Question: Briefly state, in one sentence, what is plotted here.
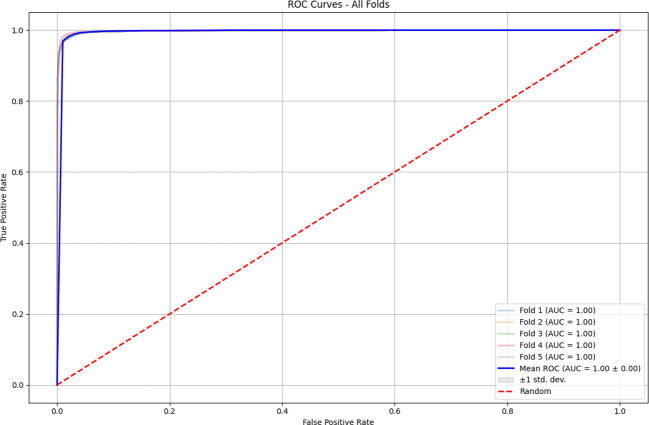
Answer: ROC curve for LSTM based model.